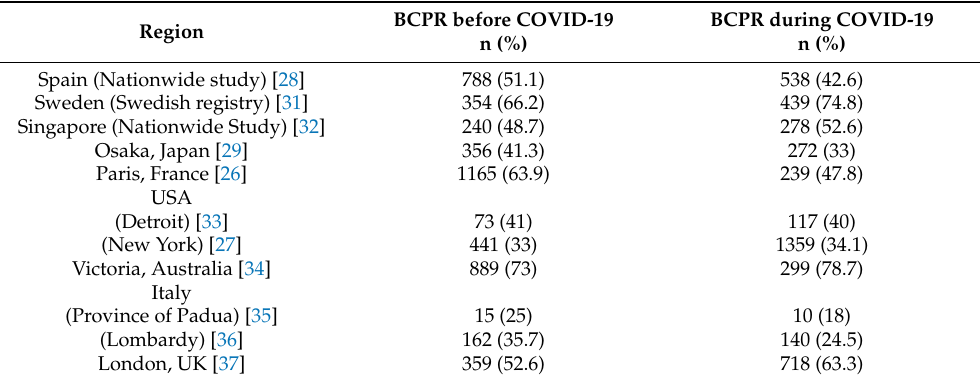
Table 1. The number of bystander CPR (BCPR) before and during the COVID-19 pandemic as published in academic